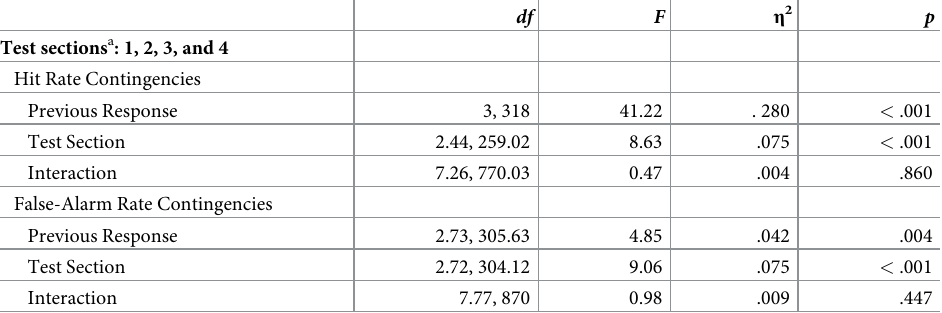
Table 5. Experiment 3: Results for ANOVAs on current hit rates and false-alarm rates given previous responses and testing